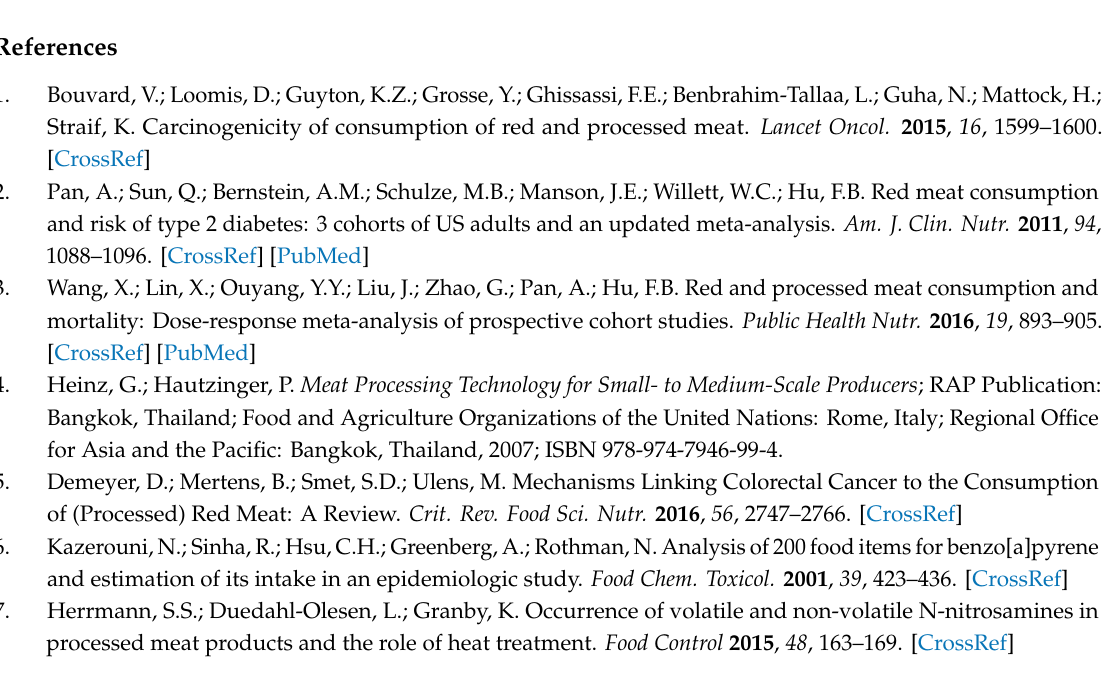
Table S1: Metabolite features with highest loadings for the first principal component (PC1) and the second principal component of a principal component analysis (PCA) of untargeted metabolomics analysis of meat in vitro digests, Table S2: Metabolite features with significantly higher levels in processed meat digests compared to pork digests, Table S3: Features significantly elevated in processed meat digests and found in pepper extracts, Table S4: Details on the recursive feature finding used to create the feature table from the HRMS raw data, Figures S1–S19: Annotation evidence of compounds elevated in processed meat. The raw data files have been deposited on MetaboLights (MTBLS1741)